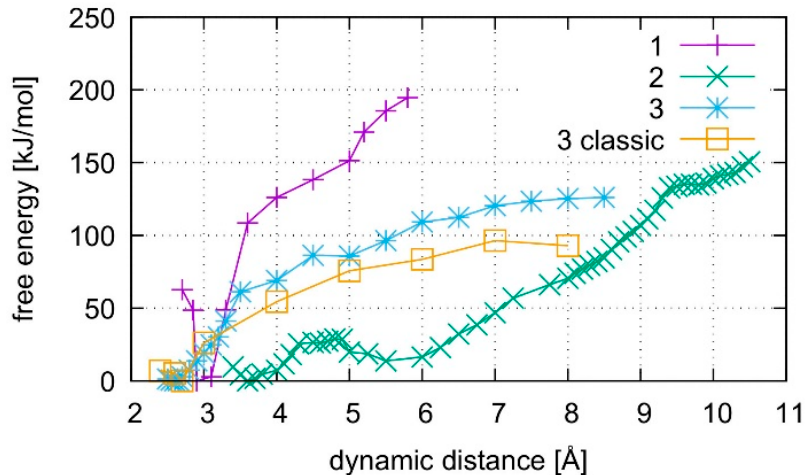
Figure 12. Comparison of free energies for the dissociation of structures 1 – 3 . Structures 1 and 2 contain the dinuclear Hg(II)-mediated base pair, whereas structure 3 is the analogous mercury-free duplex. Structure 1 starts from a QMMM-optimized geometry, whereas structure 2 starts after QMMM-MD, and structure 3 is simulated by both classical and ab initio MD.